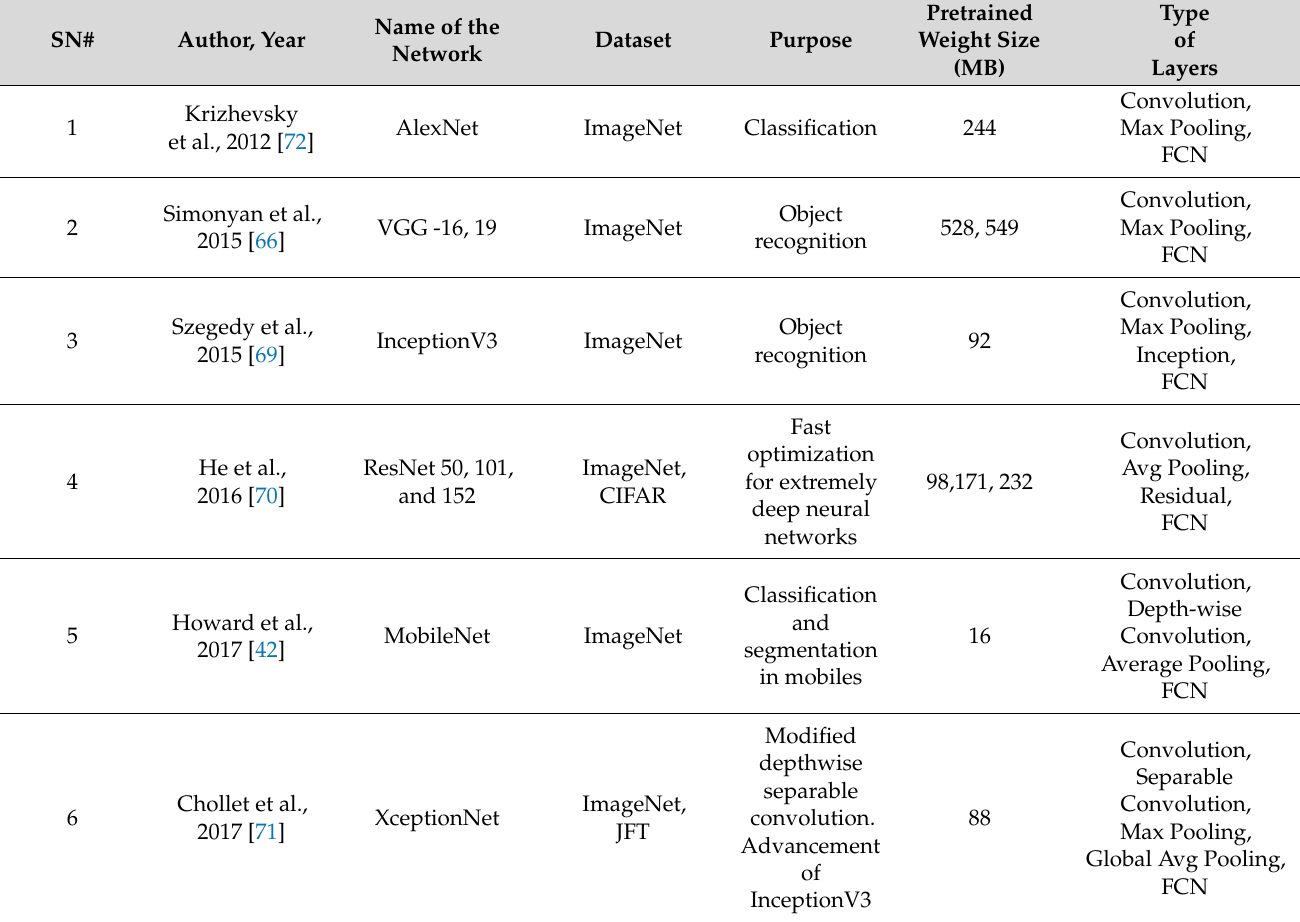
Table 8. Comparison of TL